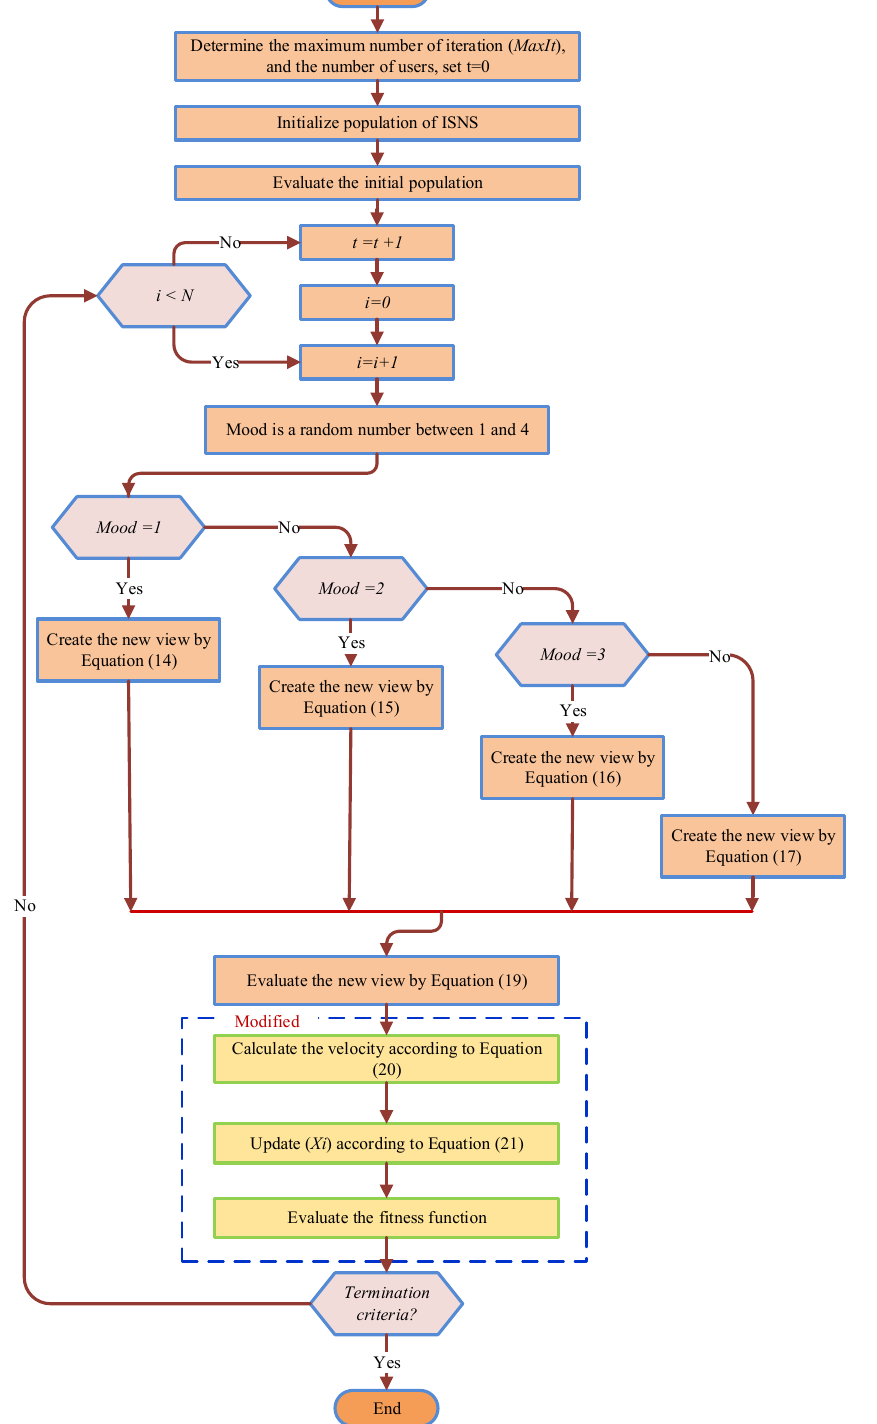
Figure 8. The flowchart of the ISNS algorithm.